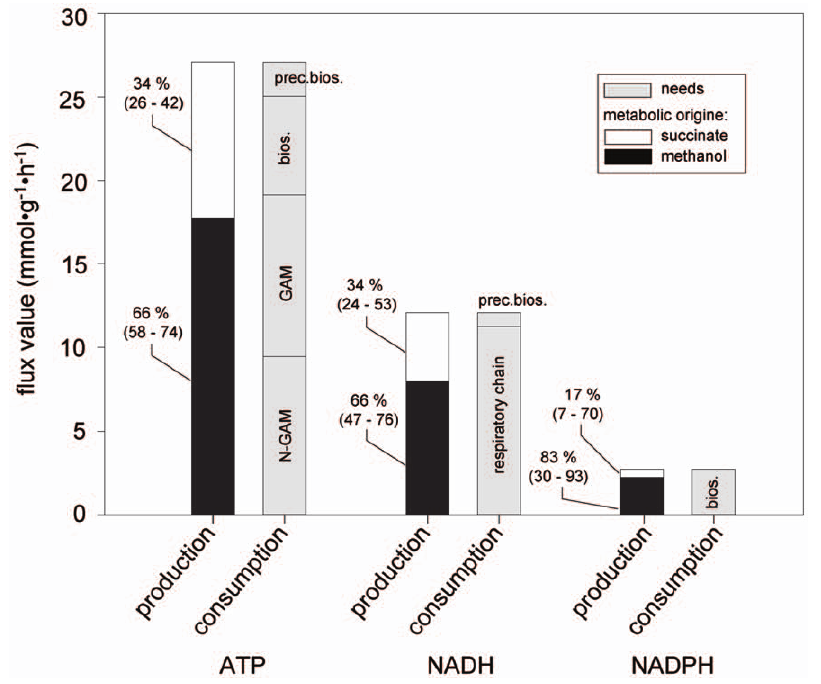
Figure 5. Metabolic contribution of succinate and methanol in energetics (ATP, NADH, NADPH) during co-consumption calculated by metabolic flux analysis through the genome-scale metabolic network of M. extorquens AM1 [ 20 ] . Methanol and succinate contributions are indicated in black and white, respectively, for a feasible solution under the constraints of the measured experimental values (methanol uptake rate, succinate uptake rate, growth rate, CO 2 production rate). The % of their contribution to all needs is indicated at the left part of the bars; the values under the brackets are the lower and upper limits of their contributions calculated by the Flux Variability Analysis. N-GAM: non- growth-associated maintenance; GAM: growth-associated maintenance; Bios.: biomass biosynthesis; Prec. Bios.: precursor biosynthesis through the central metabolic network.